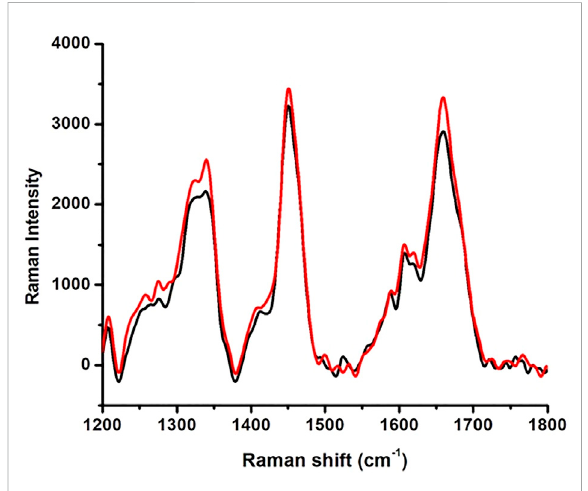
FIGURE 4 Raman spectroscopy native HSA (black line) and 4-Cl-OPD modi fi ed HSA (red line).